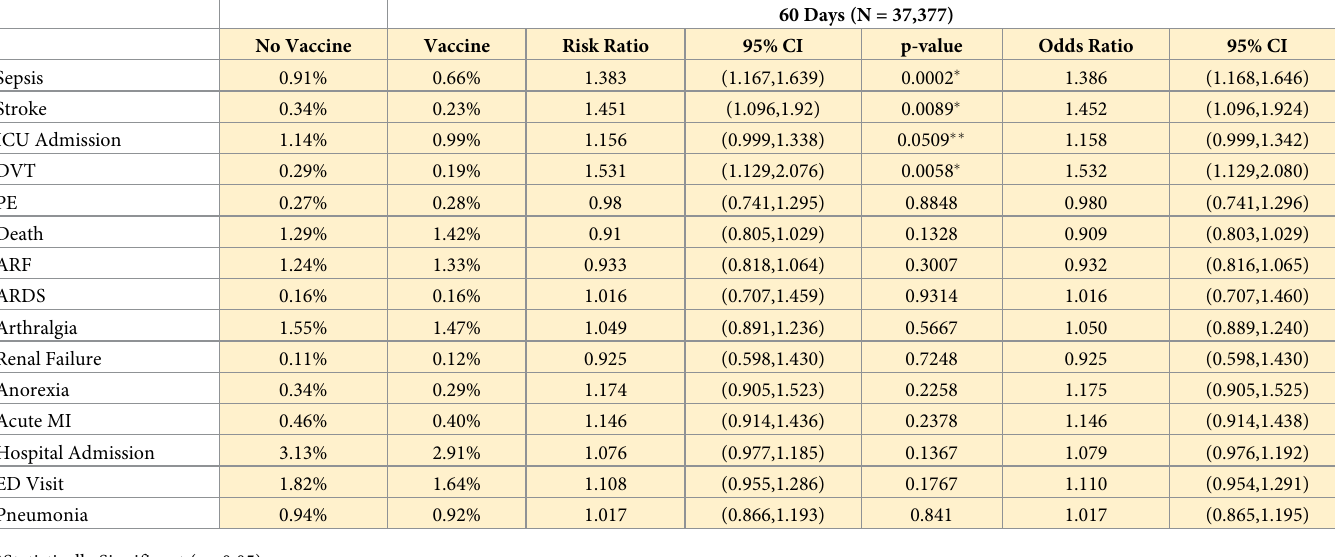
Table 3. Statistical analysis of adverse outcomes within 60 days of SARS-CoV-2-positive